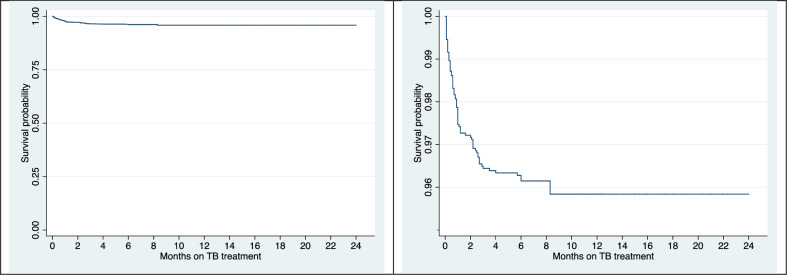
A and B1 Survival curve of patients with TB related death2 in Denmark 2009–2014. 1: Magnified view of the survival curve 2: The sum of TB related death (death from another cause had been precipitated by TB disease) and death caused by TB (TB disease lead directly to organ failure or fatal complication).